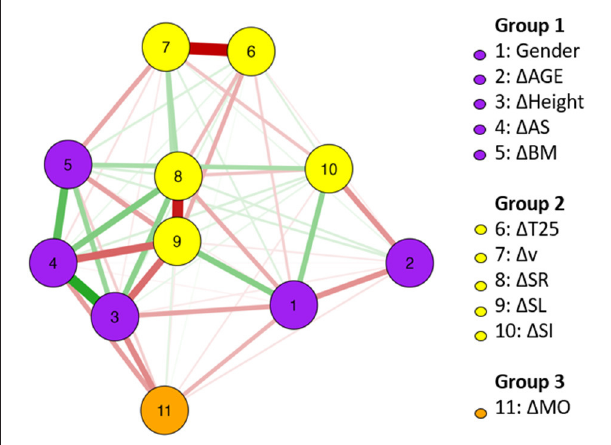
FIGURE 2 | FLY network of association between changes ( 1 ) in anthropometrics, maturation, and kinematics (using gender as a dichotomous variable); n =